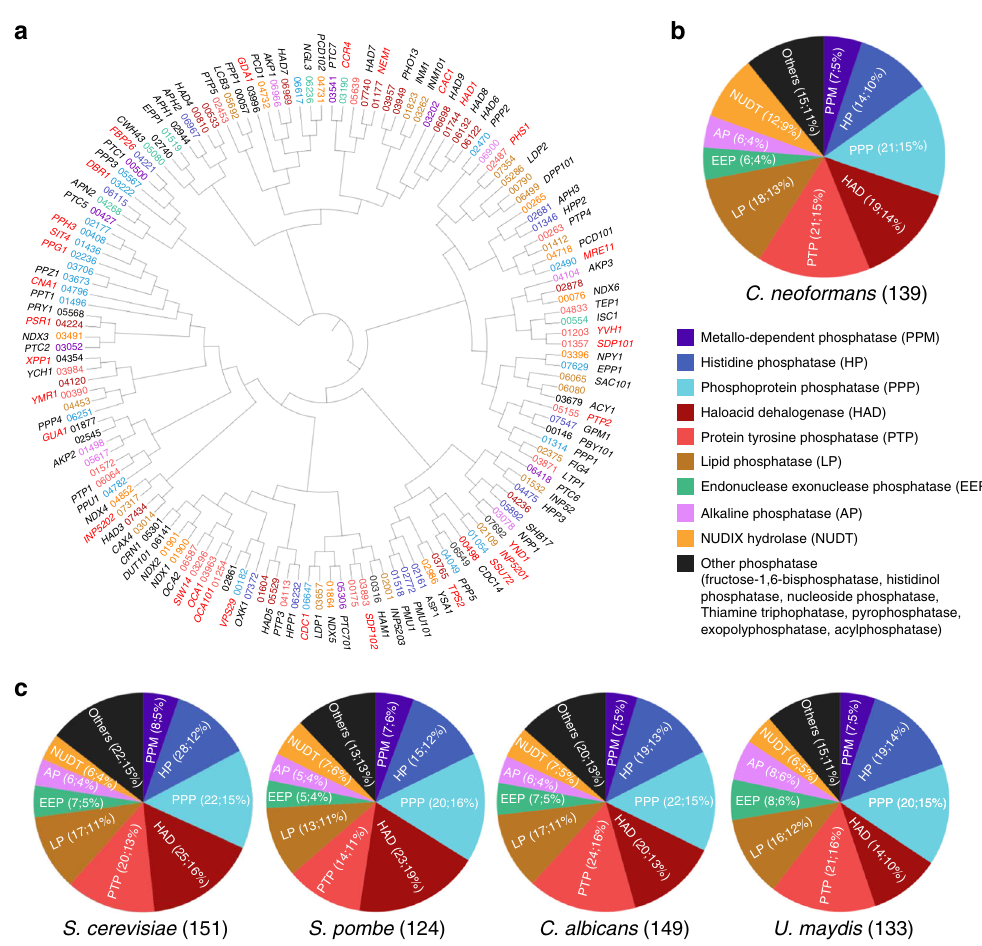
Fig. 1 Classi fi cation of phosphatases in C. neoformans and other fungal species. a Phylogenetic analysis of phosphatases utilized a protein sequence- based alignment in ClustalX2 (Science Foundation Ireland, Dublin, Ireland). These alignment data were used to illustrate the phylogenetic tree through a web-based drawing application (Interactive Tree Of Life, https://itol.embl.de). Red letters represent pathogenicity-related phosphatases in C. neoformans identi fi ed from 114 phosphatase gene-deletion mutants that we constructed. b Pie chart indicating the classi fi cation and distribution of 139 phosphatases based on phosphatase-related domain, as analysed by using the InterPro Database. c Pie chart indicating the distribution of putative phosphatase genes in the fungal species S. cerevisiae , S. pombe , C. albicans , and U. maydis surveyed and classi fi ed using the same strategies as for C. neoformans